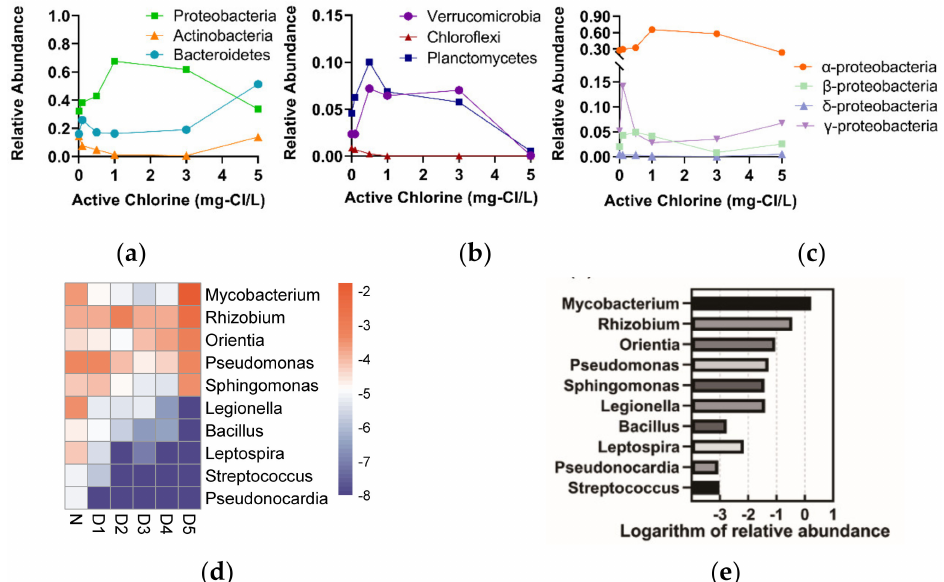
Figure 4. Relation between the chlorine addition and the bacterial response. ( a ) Dominant bacteria at phyla level, ( b ) rare bacteria at phyla level, and ( c ) bacteria in phylum Proteobacteria. ( d ) Heatmap analysis of the relative abundance of potentially pathogenic bacteria identified in the experiment under different conditions. The raw data were processed with logarithmic transformation. ( e ) The relative abundance of the potentially pathogenic bacteria, and the values represent the maximum abundance among